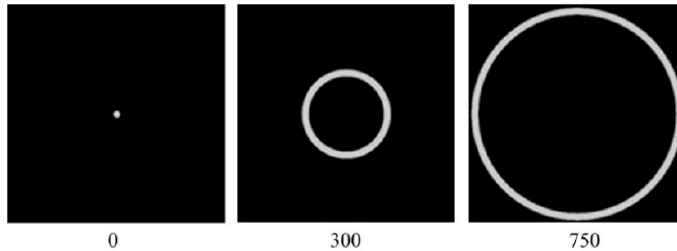
Figure 2. Different stimuli visual fields.